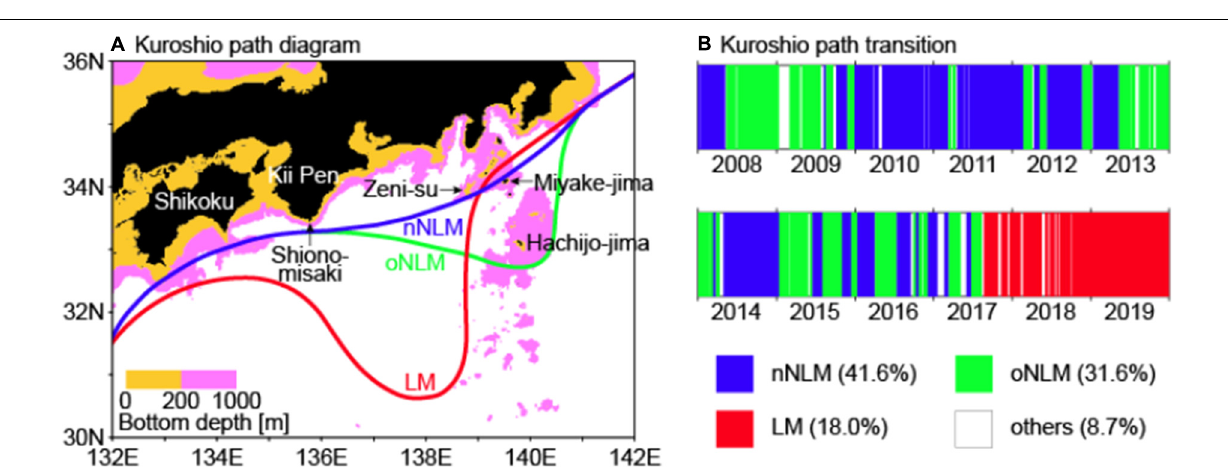
FIGURE 2 | (A) Three typical paths of the Kuroshio: nearshore non-large meander (nNLM), offshore non-large meander (oNLM), and large meander (LM). These path lines were traced from Kawabe (1995). (B) Transition of the Kuroshio path during the period 2008–2019 as defined by using the simulation